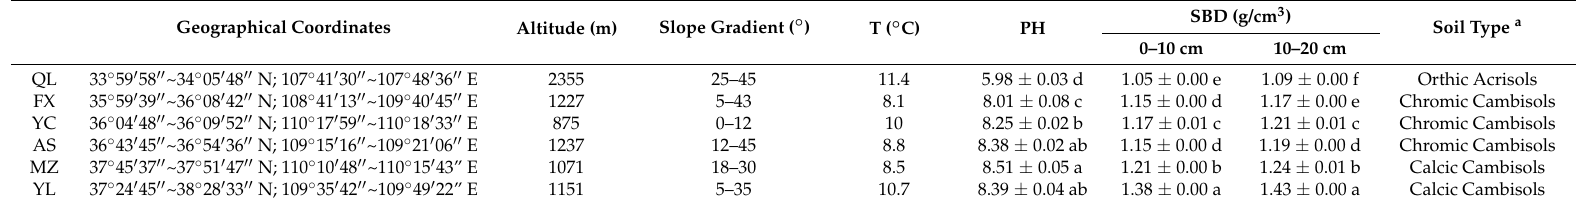
Table 1. General information of the sampling sites in our study.